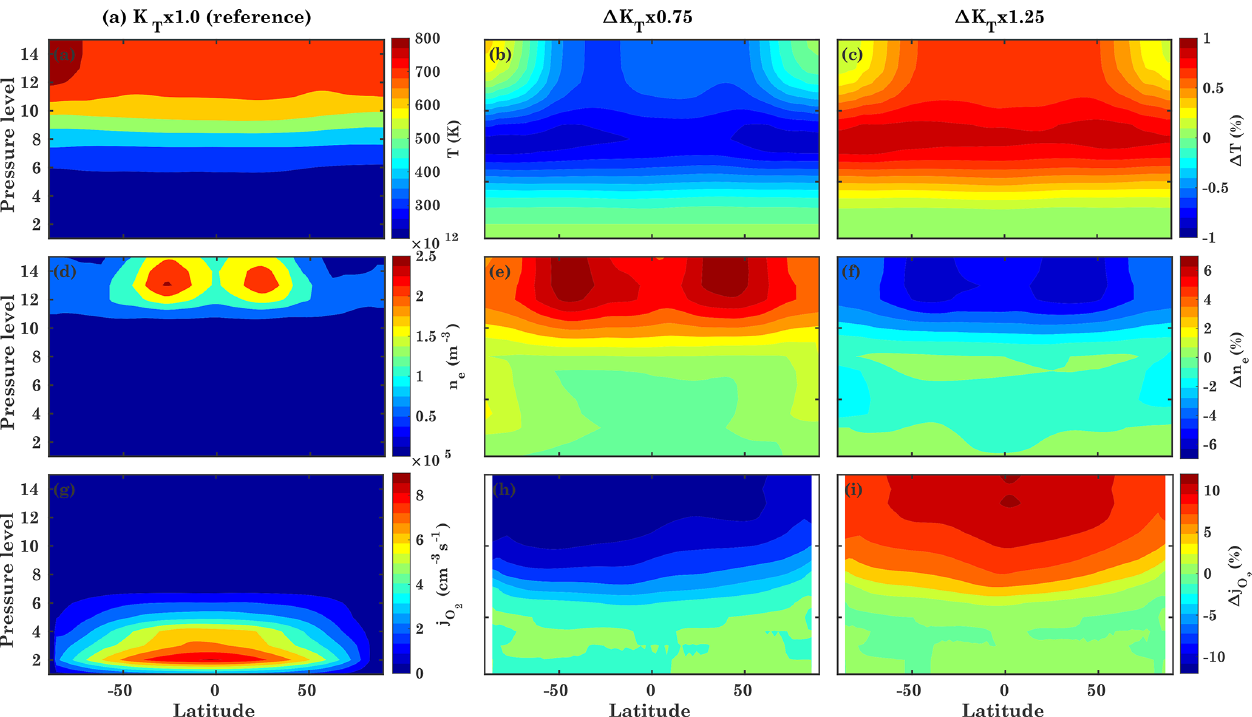
Figure 10. (a) CTIPe-simulated T (upper row), n e (middle row), and j O the percentage difference between the K T × 1 . 0 simulation and the simulations with modified eddy diffusion conditions: (b) K T × 0 . 75 and (c) K T × 1 .